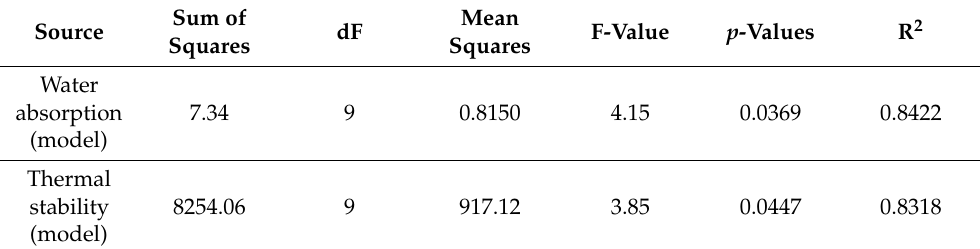
Mean F-Value p -Values dF Squares